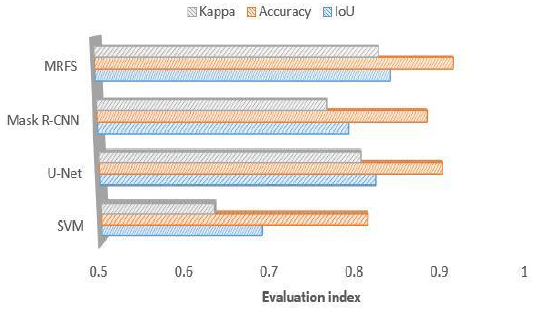
Figure 10. Comparison of MRFS, Mask R-CNN, u-net, SVM and KNN on the village buildings extraction.